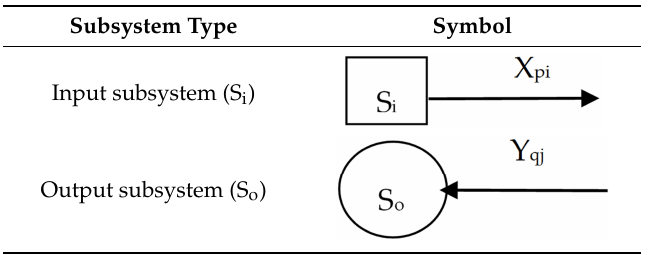
Table 2. Symbols for subsystems and flows. Figure 3. The decomposable structural diagram of the designed system. Figure 3. The decomposable structural diagram of the designed